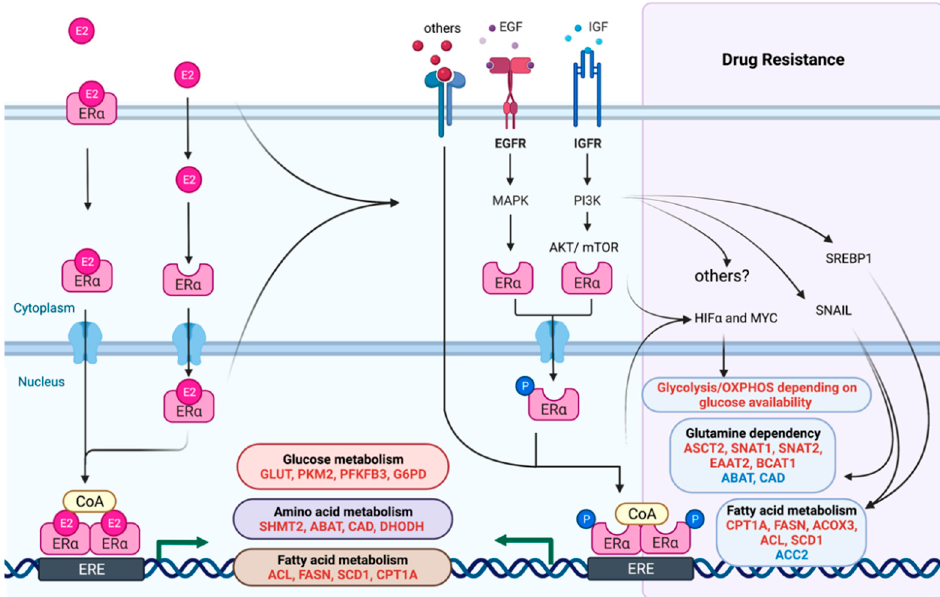
Figure 2. Dynamic changes in major metabolic pathways by ER in sensitive and resistant breast cancer. Upregulated genes are shown in red and downregulated in blue.